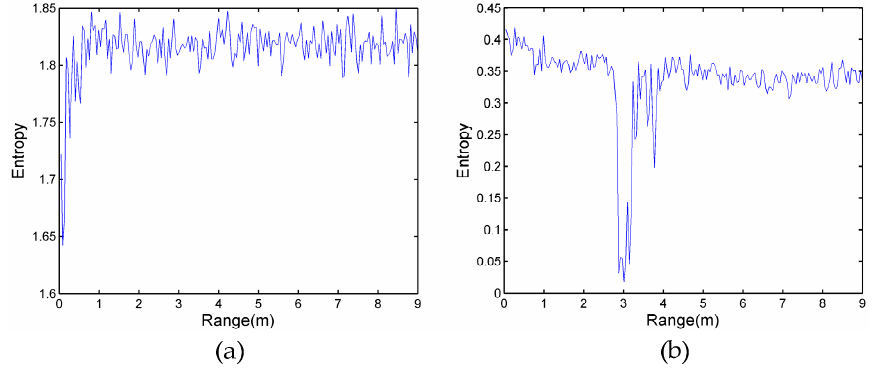
Figure 8. ( a ) The value of wavelet entropy with no human target; and ( b ) the value of wavelet entropy with one human target located at 3 m.